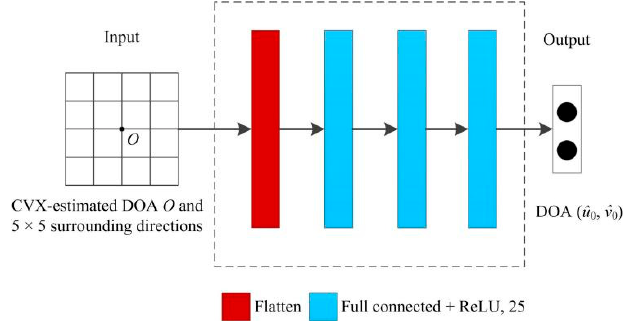
Figure 2. Estimated DOA of CVX method: ( a ) normalized beam pattern; ( b ) estimated DOA O and 5 × 5 surrounding directions.